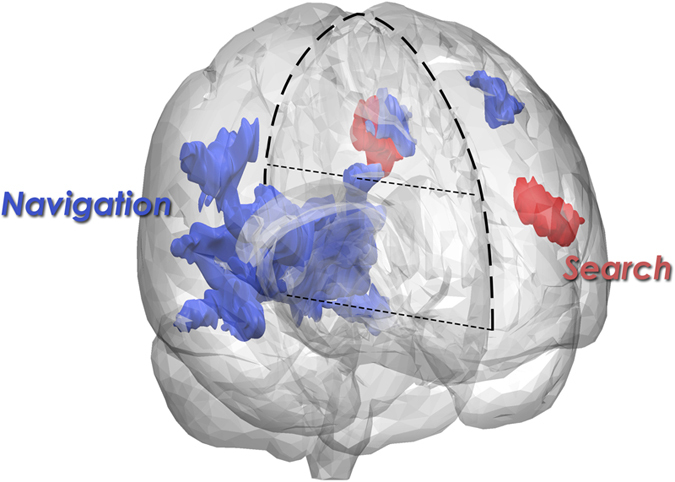
A 3D model illustrating bilateral posterior regions activated for folder navigation (blue), and left inferior frontal activation for search (red).Results uncorrected, p = 0.001, a minimum cluster size k = 10, and an FDR correction at cluster level of p < 0.05. The bold dotted line marks the external outline of the brain, while the two thin dotted lines mark the center-line, dividing between the left and right hemispheres. The figure was produced by creating a 3-D model of the standard MNI152 brain using the 3D Slicer open access software (www.slicer.org/). The 3-D activations were then constructed and placed in the model using the information provided by each of the 2-D slices on the X Y and Z planes as produced by SPM. Permission to publish under Open Access is granted by the authors who are copyright owners.